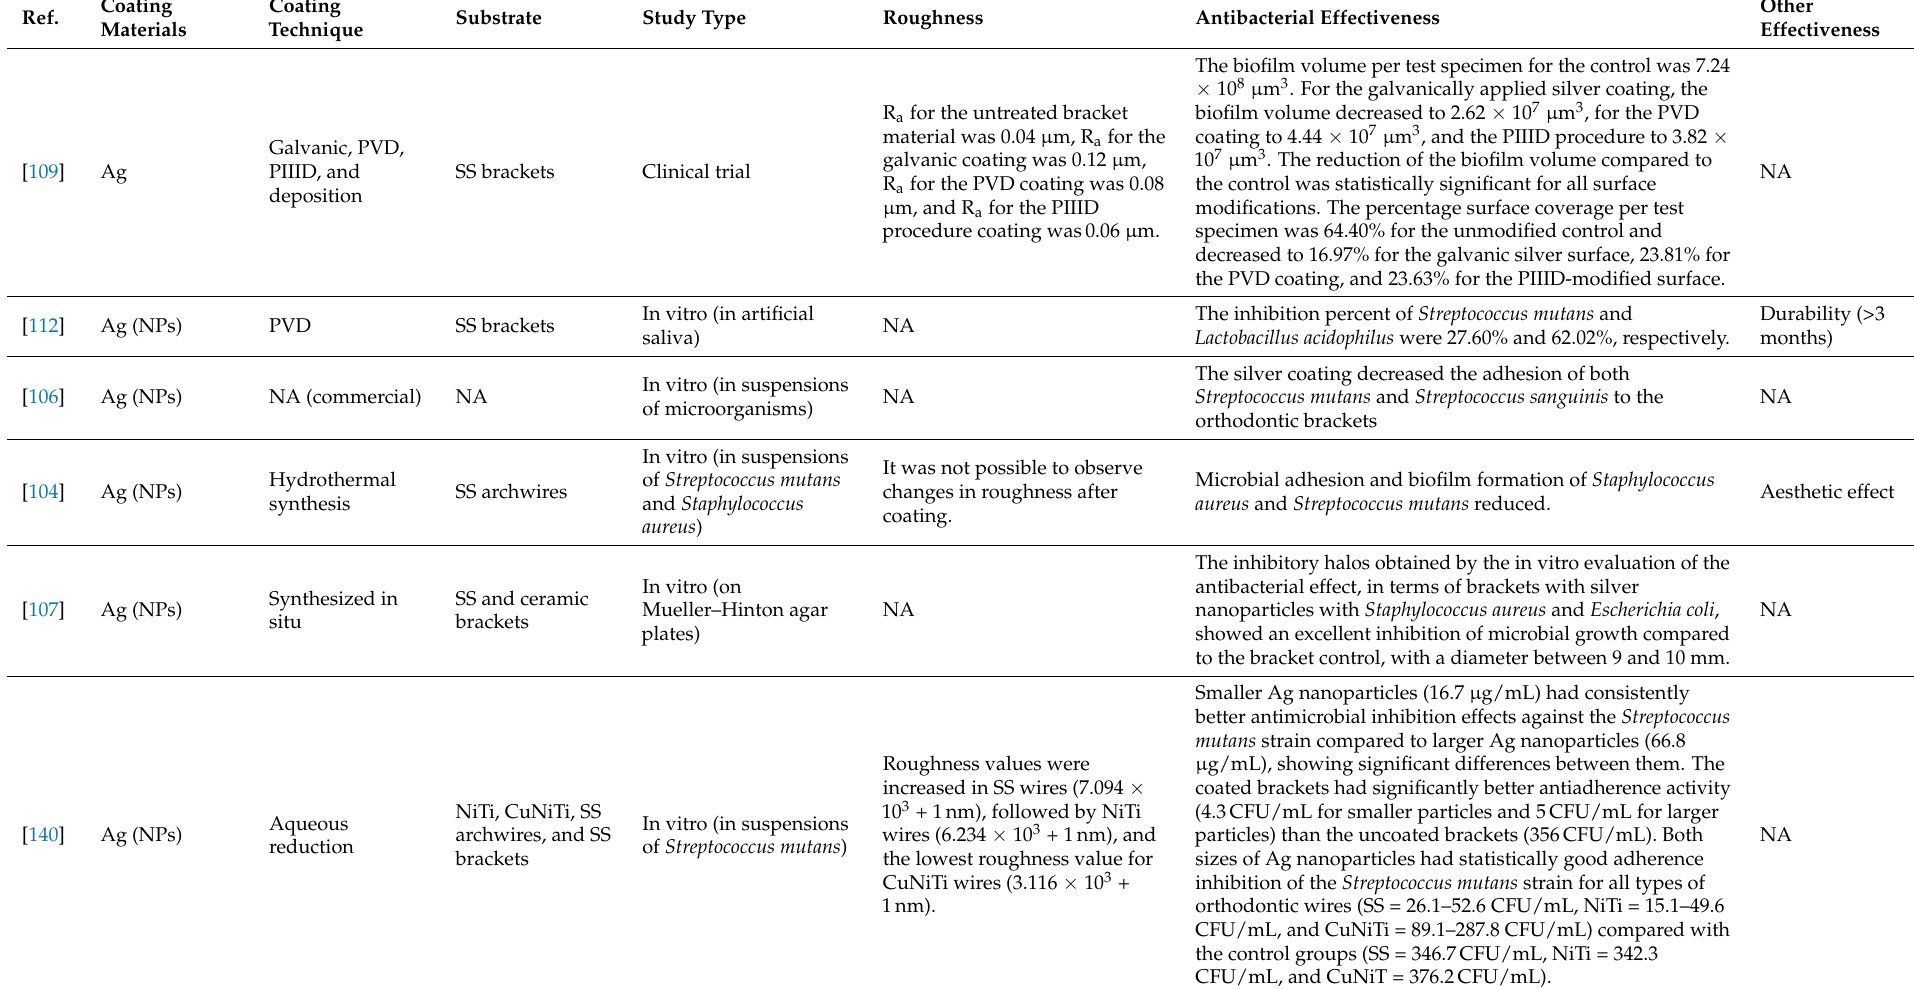
Table 2. Recent studies on antibacterial coatings for orthodontic